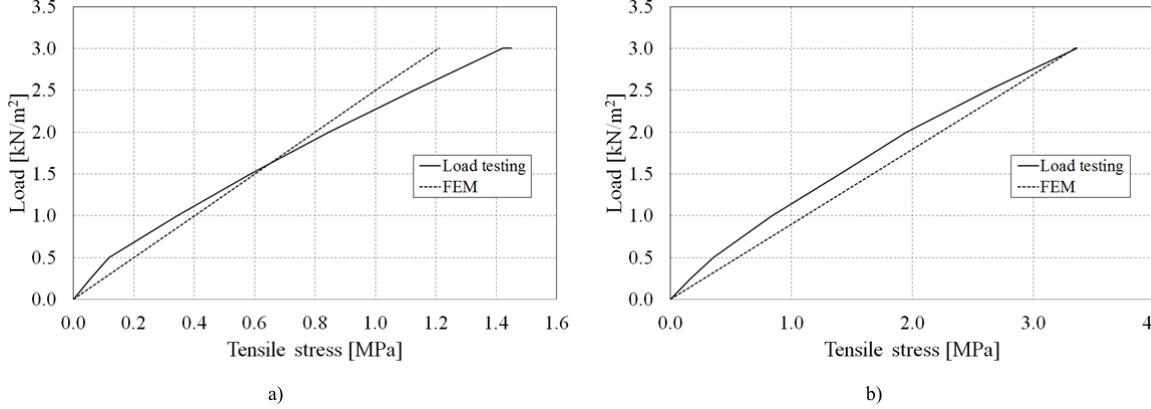
Fig. 13 Comparison of the measured and FEM tensile stress a) σ g.B+ in glass at section B-B and b) σ s.B+ in steel at section B-B.